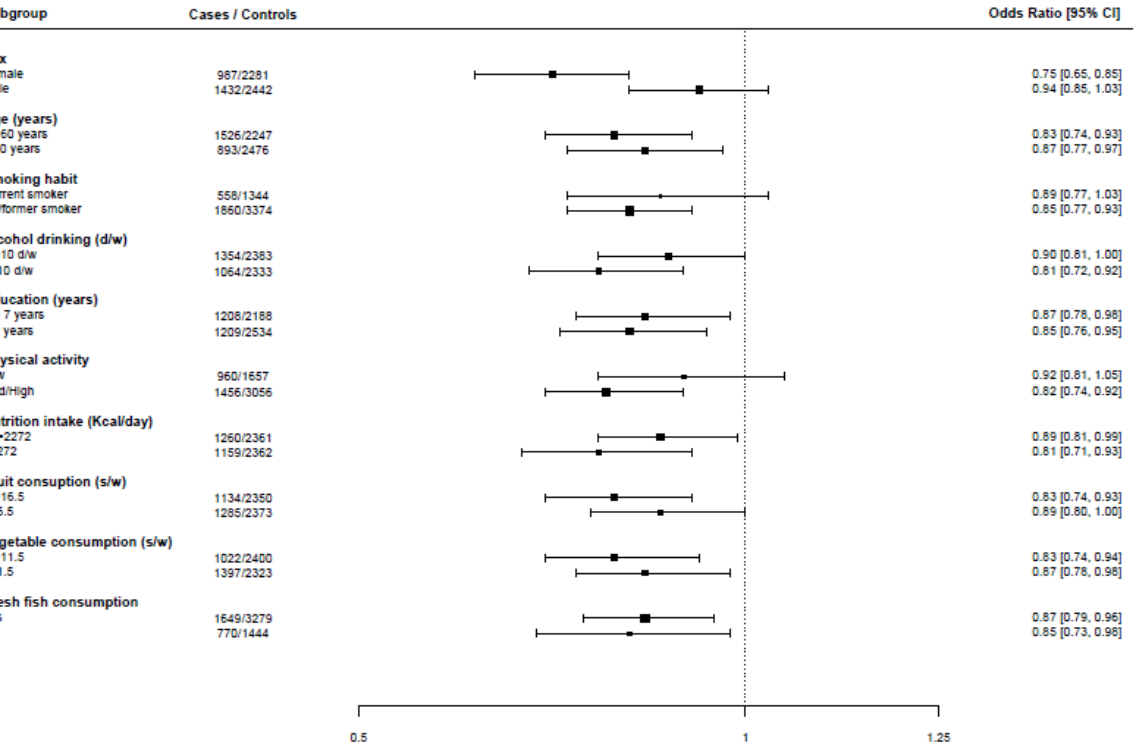
Figure 2. Odds ratios (95% confidence interval) of risk of colorectal cancer according to consumption of canned fish in strata of selected covariates. Legend of Figure 2. d/w: drinks/week; s/w: serv- ings/week.